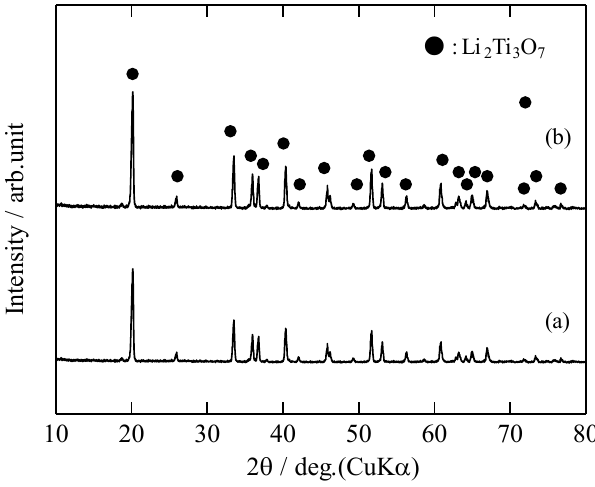
Figure 2. XRD pattern of RLTO powders calcined at 1100  C for 24 h under ( a ) air; and ( b )